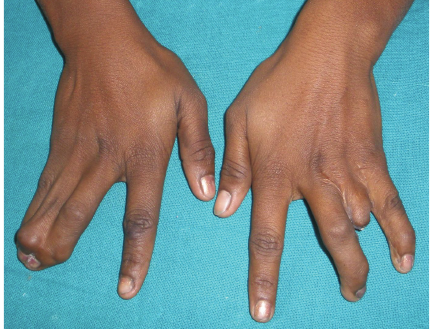
Figure 2: Hands showing syndactyly of fingers.